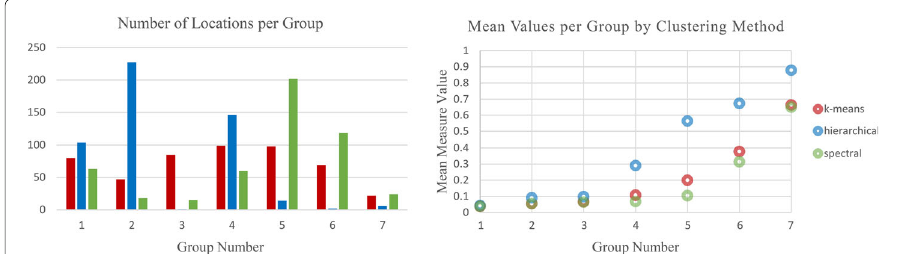
Fig. 9 Numbers of locations and mean values across the 300 core measures per group for the three clustering techniques. Hierarchical clustering more evenly spaces out the values to create groups that vary more in their characteristics by essentially creating fewer (i.e., empty) groups